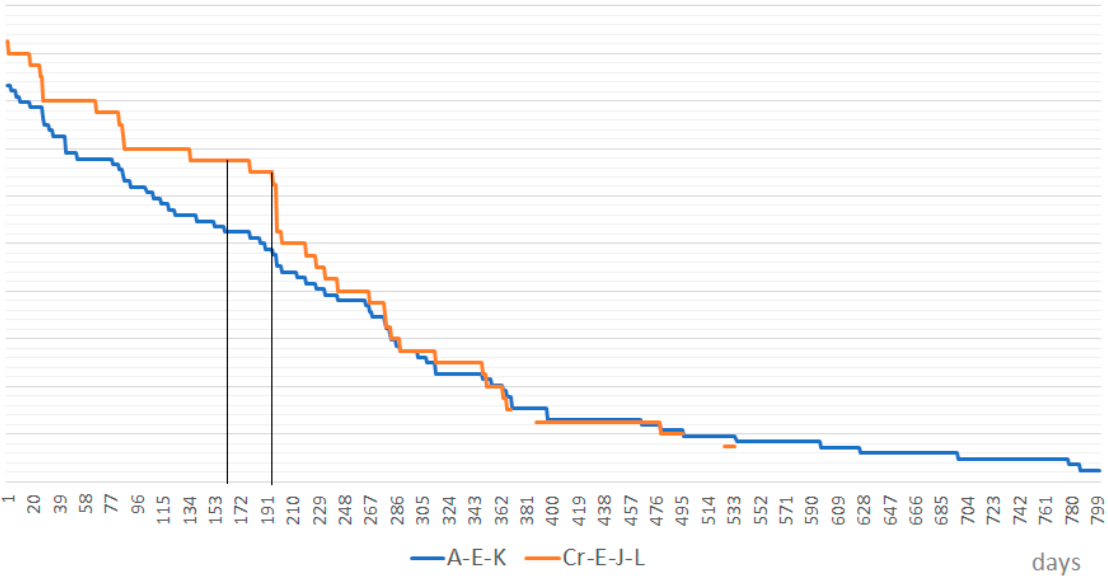
Figure 10. The confidences of the rules for A-E-K and CrEJL for different numbers of days as the threshold of the head (delay).